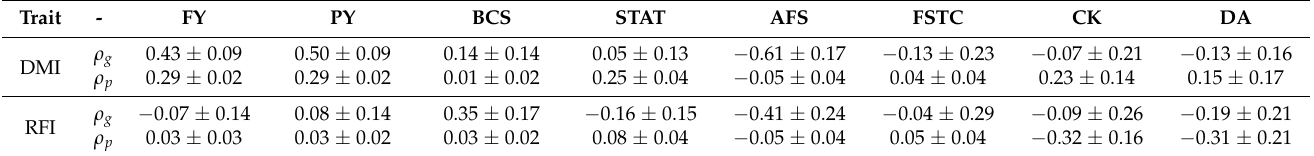
Table 3. Additive genetic and phenotypic correlation estimates ( ± standard errors).